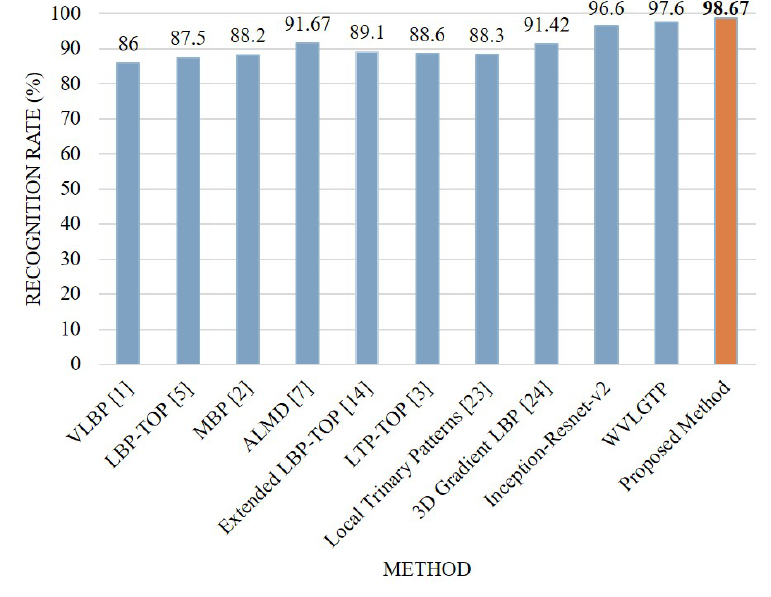
Figure 13. Comparison between the proposed method and other state-of-the-art approaches on the UT interaction